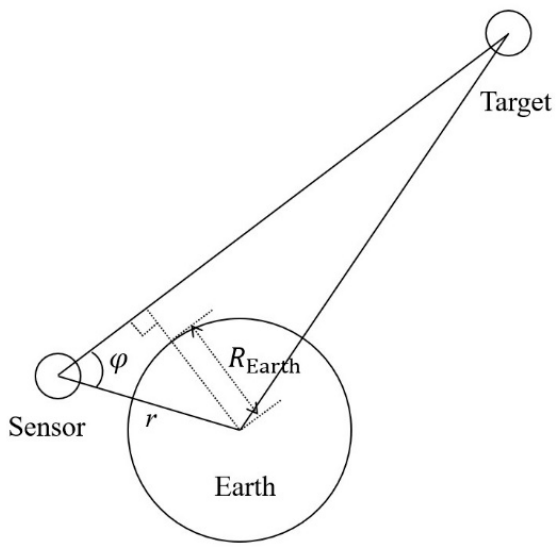
Figure 1. Judgment conditions for visibility.